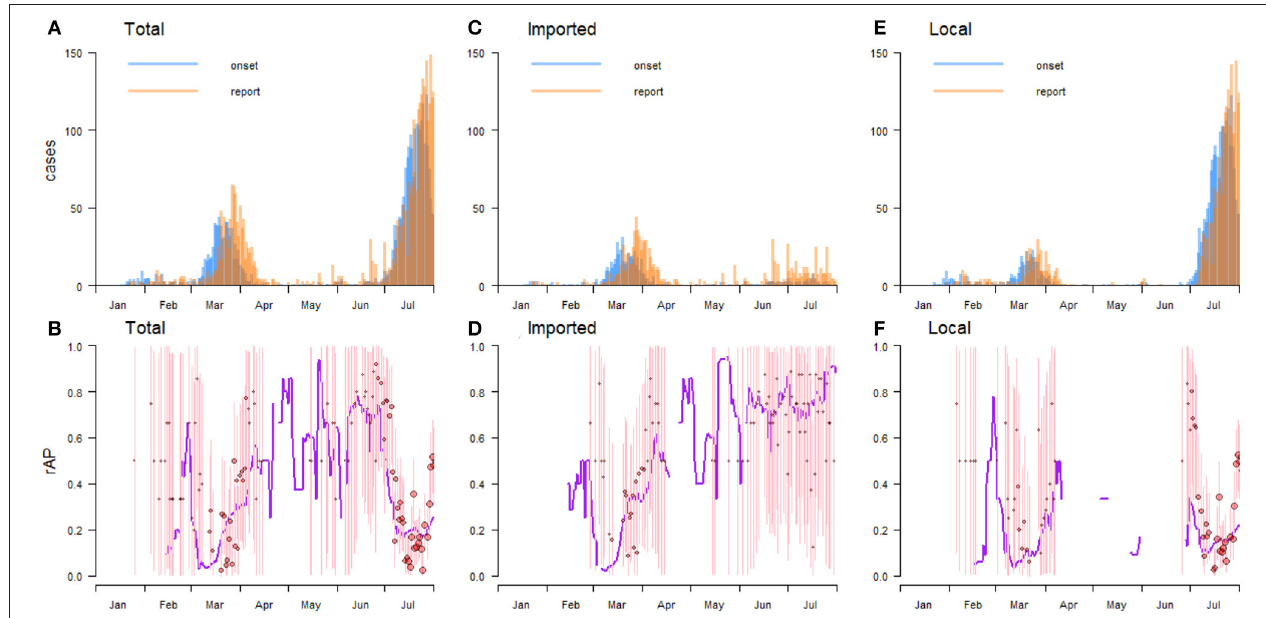
FIGURE 1 | The daily number of total (A) , imported (C) , and local (E) COVID-19 confirmed cases in Hong Kong. The daily reported asymptomatic proportions (rAPs) among the total (B) , imported (D) , and local (F) cases. In panels (B,D,F) , the red circles represent the daily rAP, where the circle size represents the sample size, the pink vertical bar represents the 95% confidence interval (95% CI), and the purple curve represents the crude